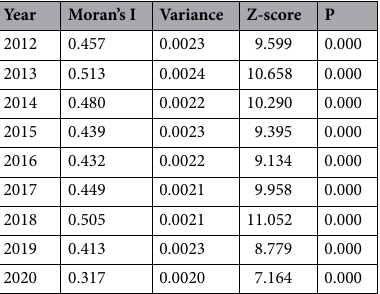
Table 1. Global Moran’s I autocorrelation value for annual malaria cases in northwest Ethiopia,